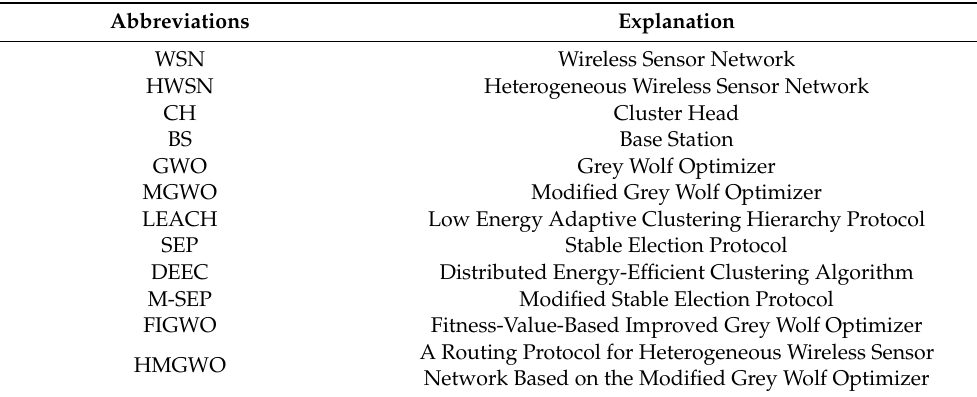
Table 1. Abbreviations used in this